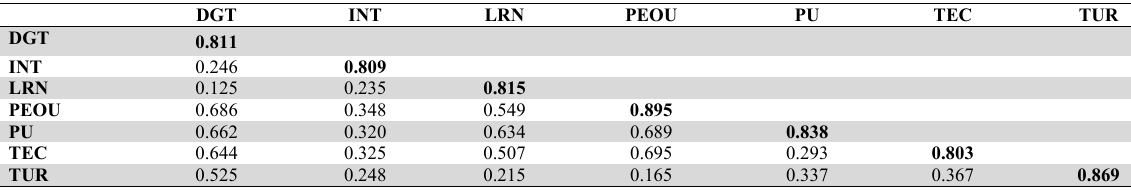
Fornell-Larcker Scale